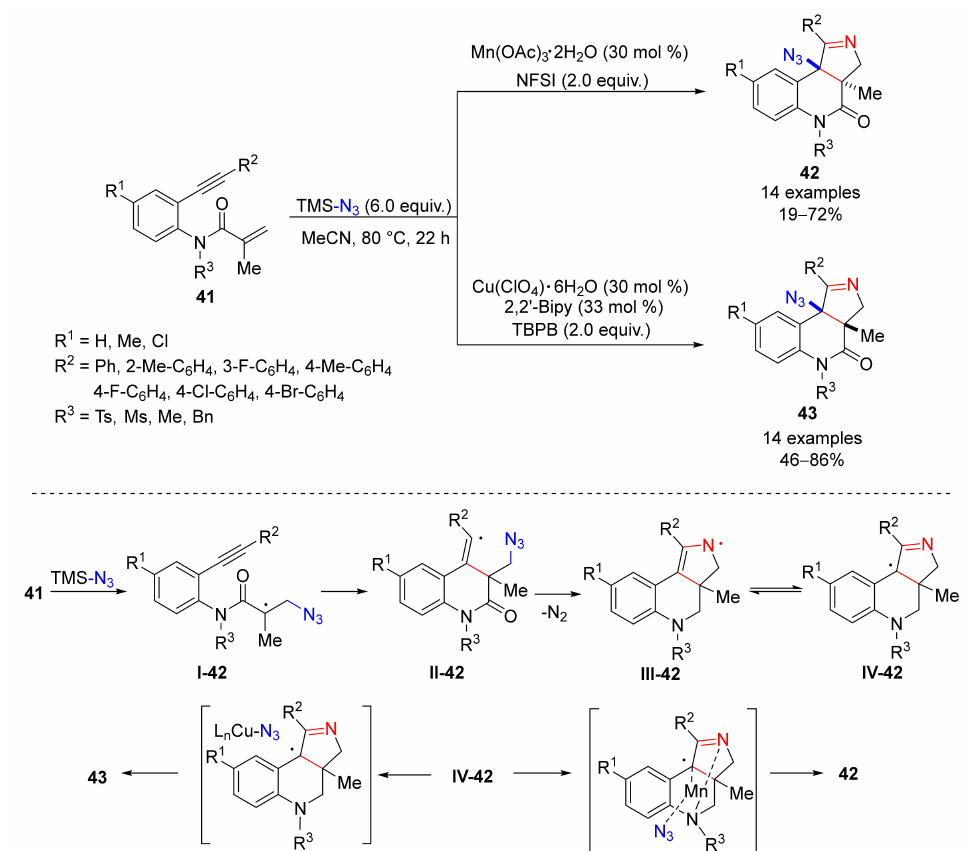
Scheme 41. Imination / azidation